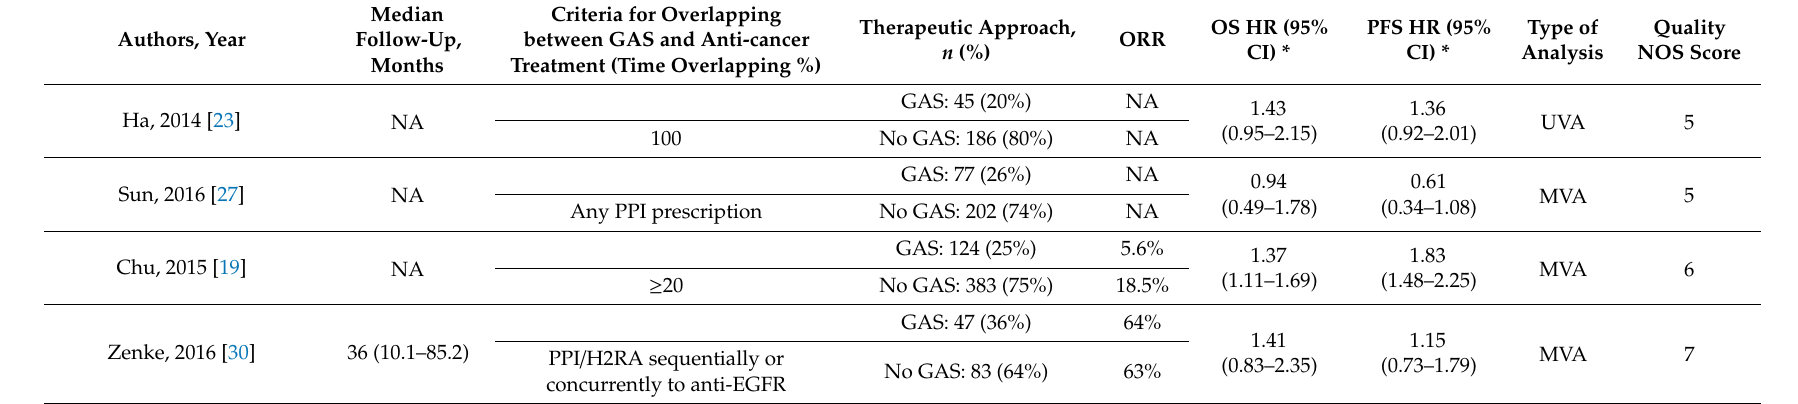
Table 2. Response and survival outcomes in the analyzed